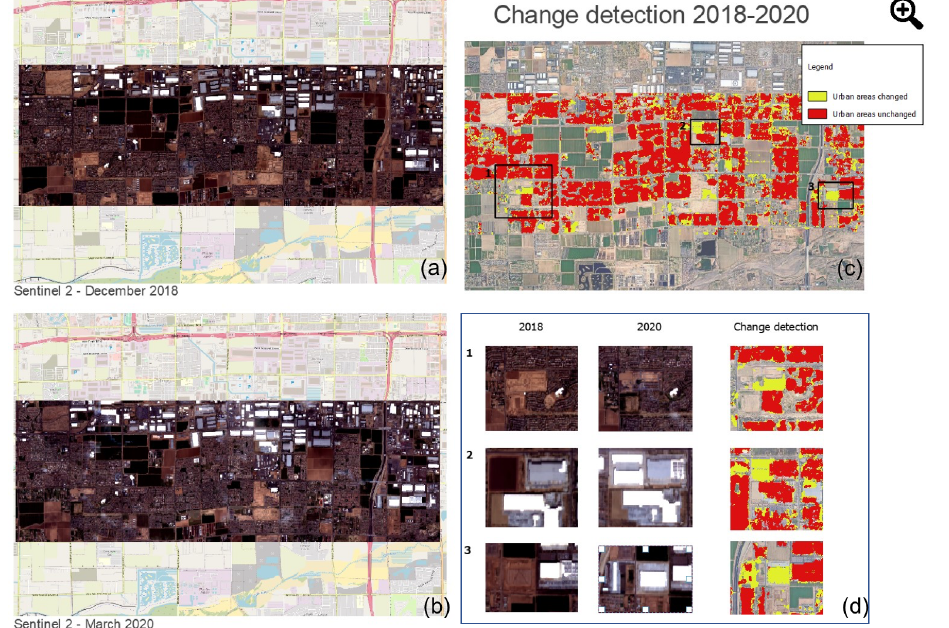
Figure 7. Detail of change map for the period December 2018–March 2020. The first column shows a subset of Phoenix, respectively, on December 2018 ( a ) and March 2020 ( b ); the second column shows change detection results ( c ) and detail ( d ), where relevant changes are correctly detected (yellow